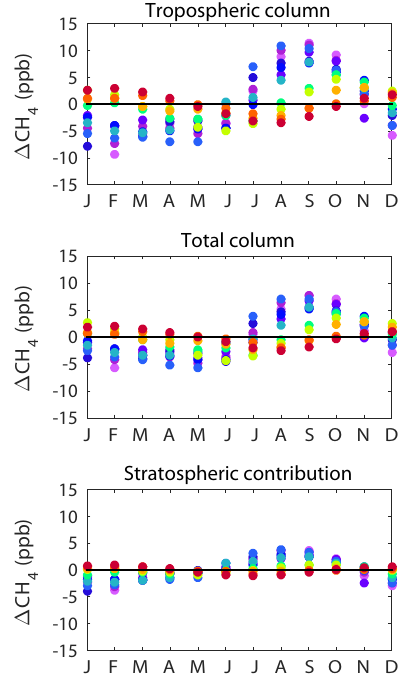
Figure 2. Seasonality of the difference between base and aseasonal CH 4 for tropospheric, total and stratospheric contribution to total columns. Site colors are as in Fig.